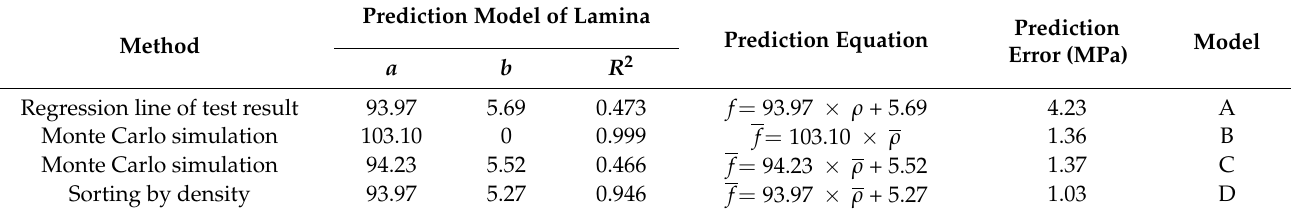
Table 6. Prediction error of the four prediction